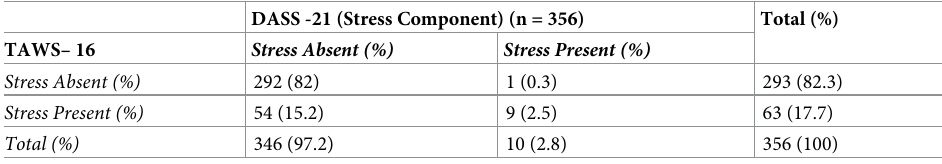
Table 4. Criterion validity–TAWS-16 v/s stress component of DASS–